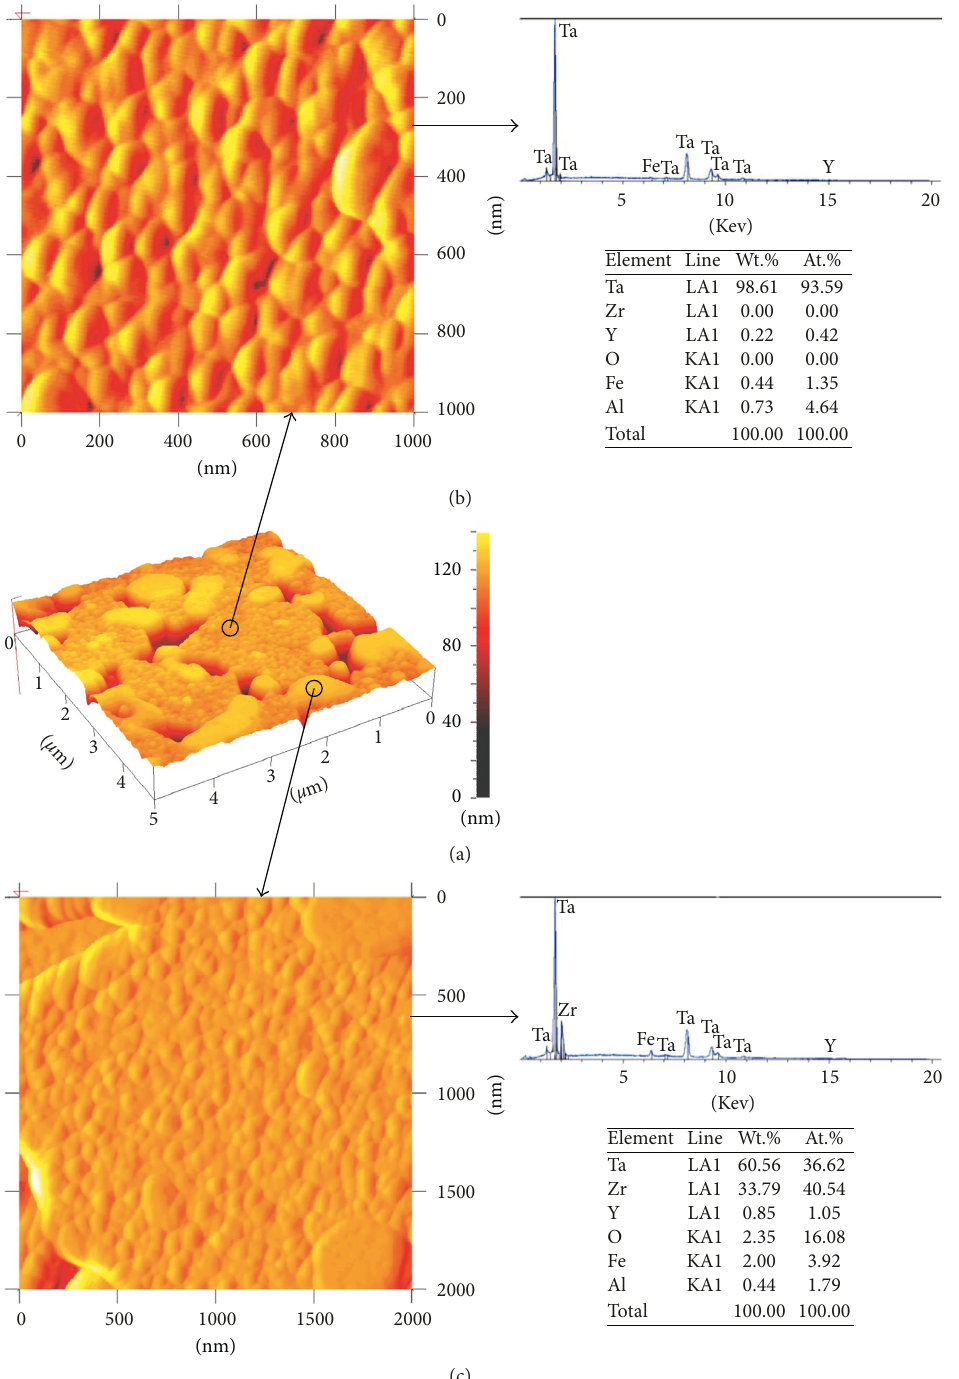
Figure 9: Example AFM images and EDS analysis showing the phase distribution in the consolidated bulk Ta-20ZrO larger area view (a), magnified area of the Ta grains (b), and ZrO 2 grains (c) with the corresponding EDS